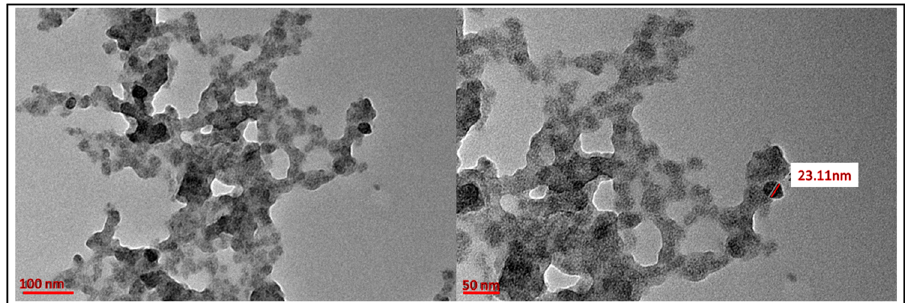
Figure 3: TEM of NP/NE.